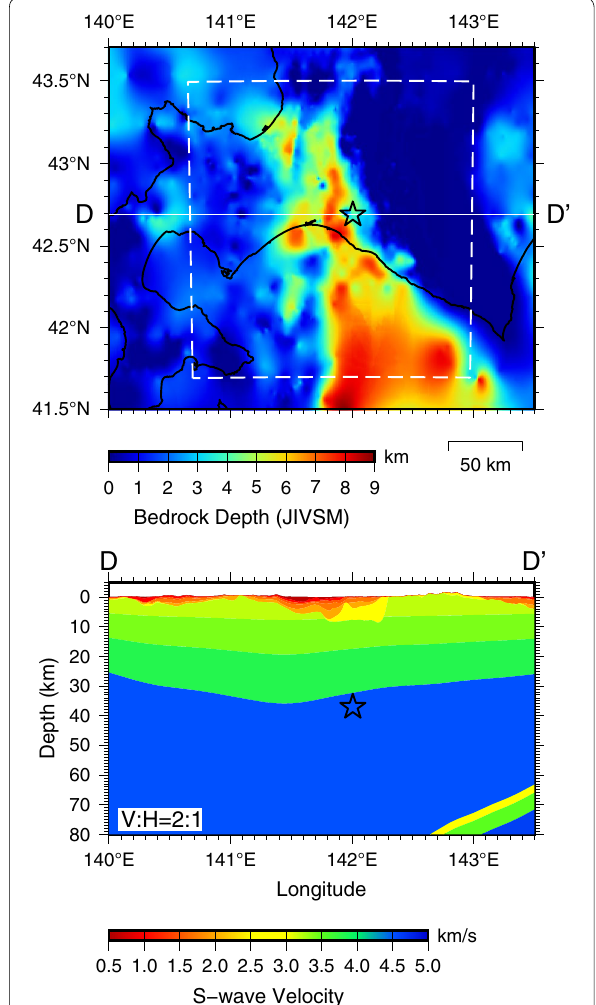
Fig. 4 Bedrock depth and vertical cross-section of JIVSM (Koketsu et al. 2012). (Top) The spatial distribution of the bedrock depth (top depth of V S 2.9 km/s) in and around the study area. The broken = rectangle represents the geographical area modeled in our FDM simulation. (Bottom) Cross-section of the S-wave velocity model in JIVSM along the line D–D ′ . The open star denotes the hypocenter of the mainshock located by